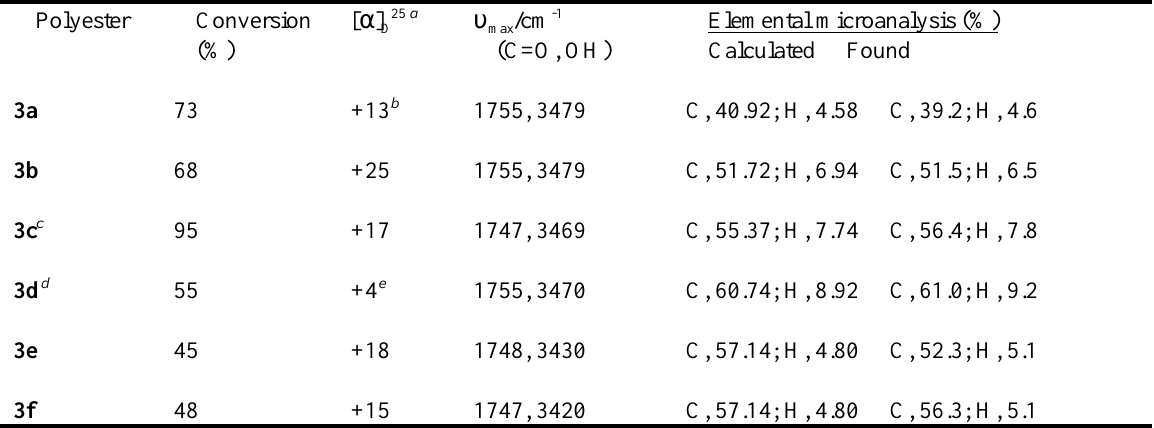
Table 1 Synthesis of polyesters 3